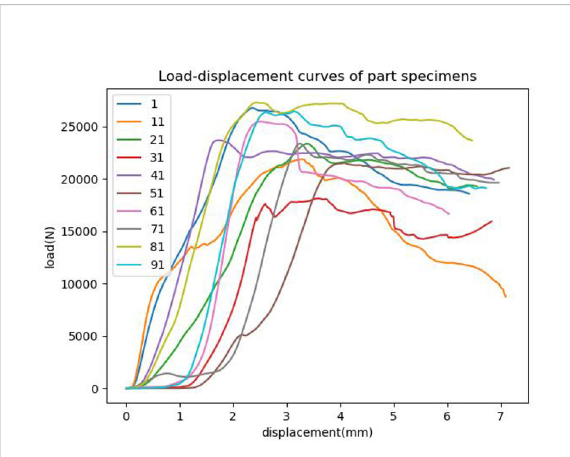
FIGURE 2 Load variation curve of experimental